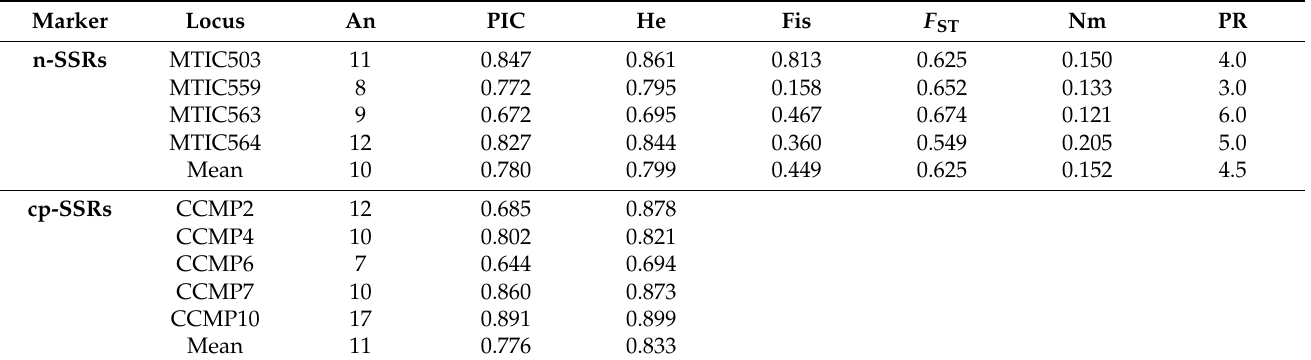
Table 2. Diversity statistics of informative nuclear and chloroplast microsatellites used to study the 11 Medicago